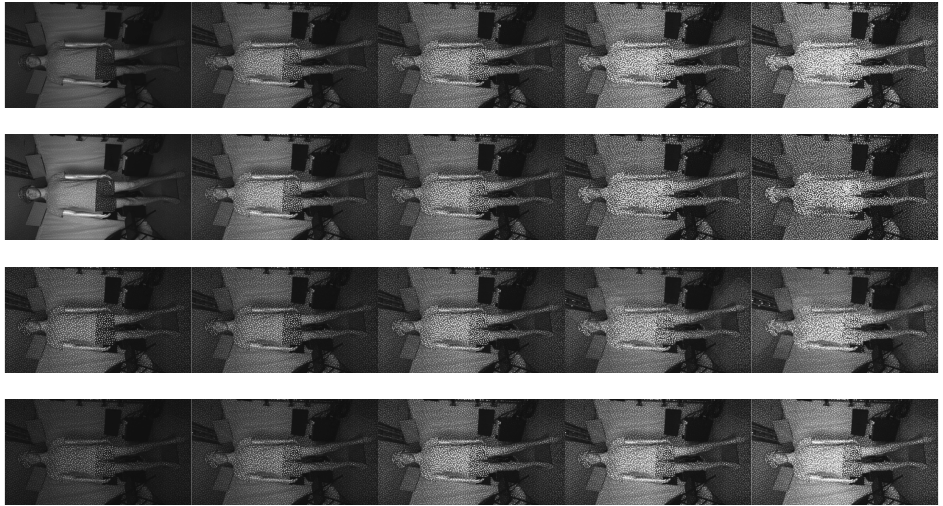
Figure 27. Left real active images, according to environments that match four attributes of active IR images. The figures show changes in the pattern intensity, pattern contrast, number of pattern dots , and global gain of IR images from top to bottom.